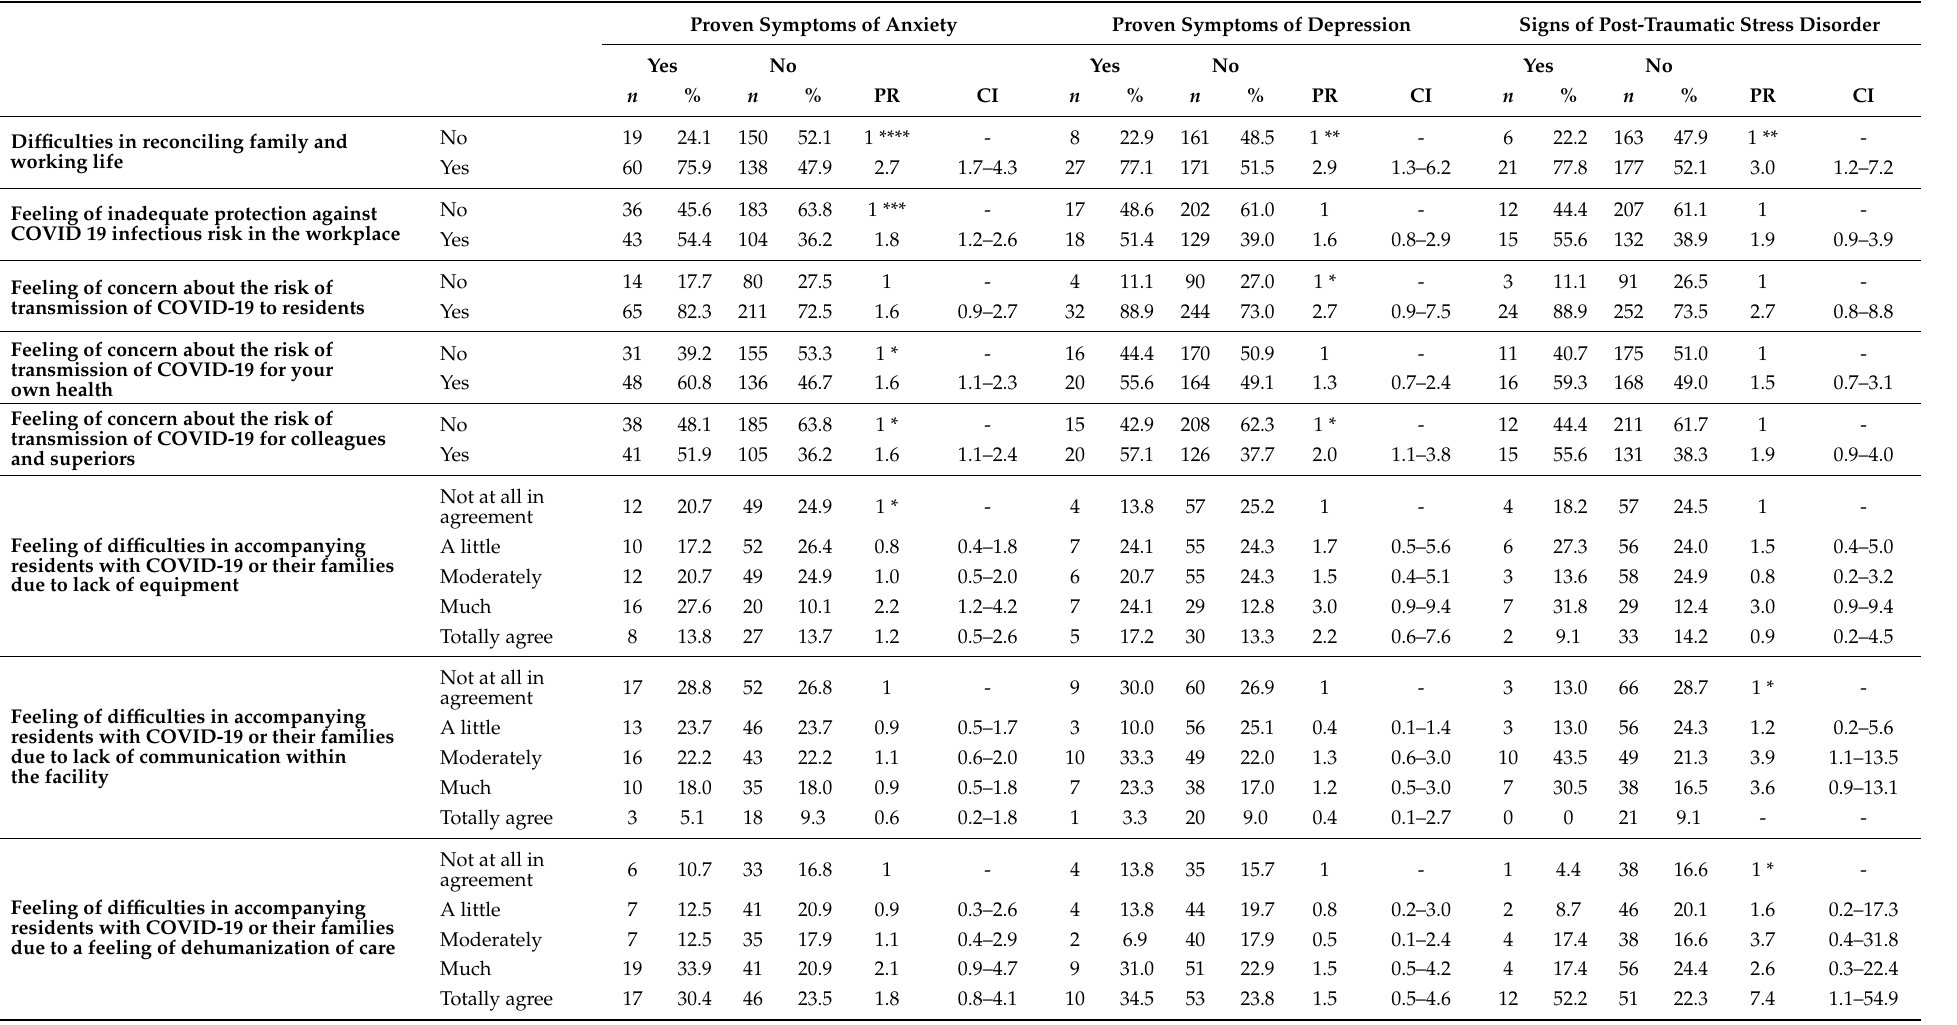
Table 2. Factors associated with anxiety symptoms, depressive symptoms, and Post-Traumatic Stress Disorder after univariate analysis. Proven Symptoms of Anxiety Proven Symptoms of Depression Signs of Post-Traumatic Stress